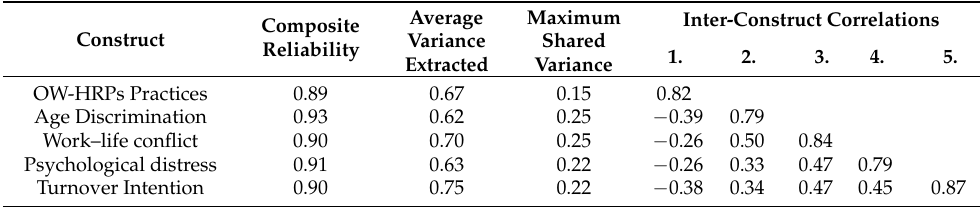
Table 2. Instrument reliability and validity.